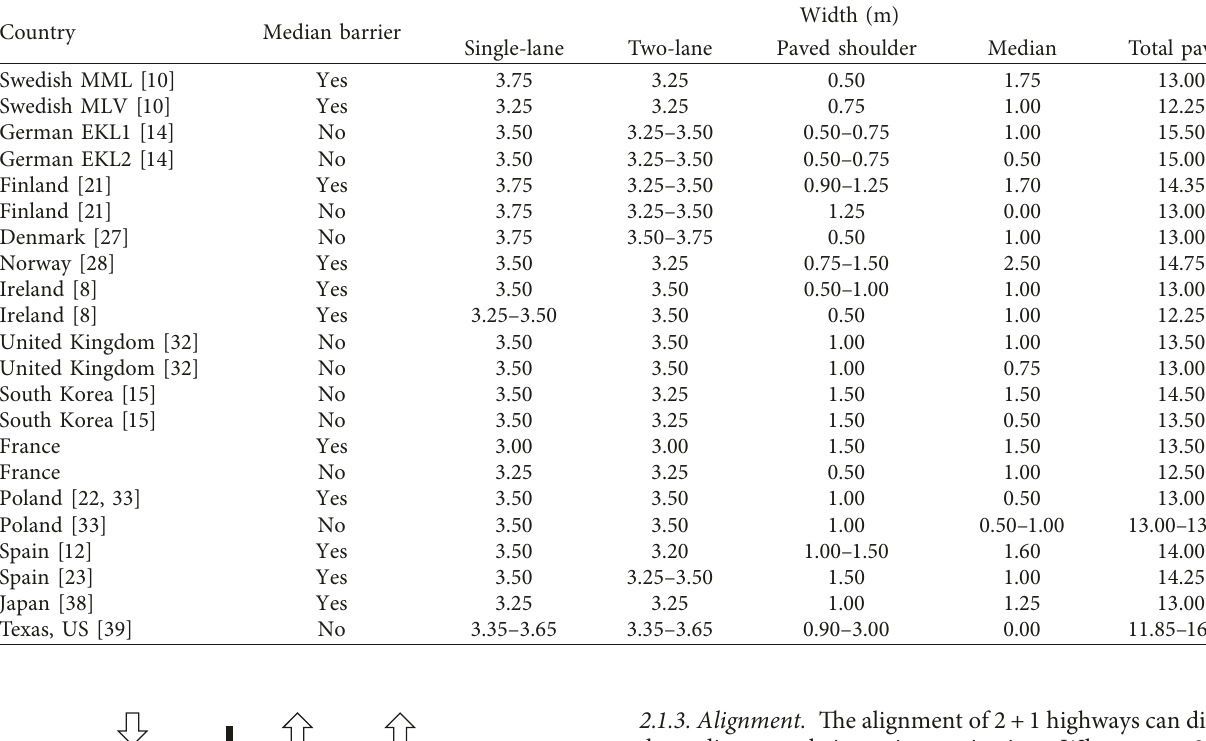
Table 2: Comparison of international 2 +1 roadway cross sections.